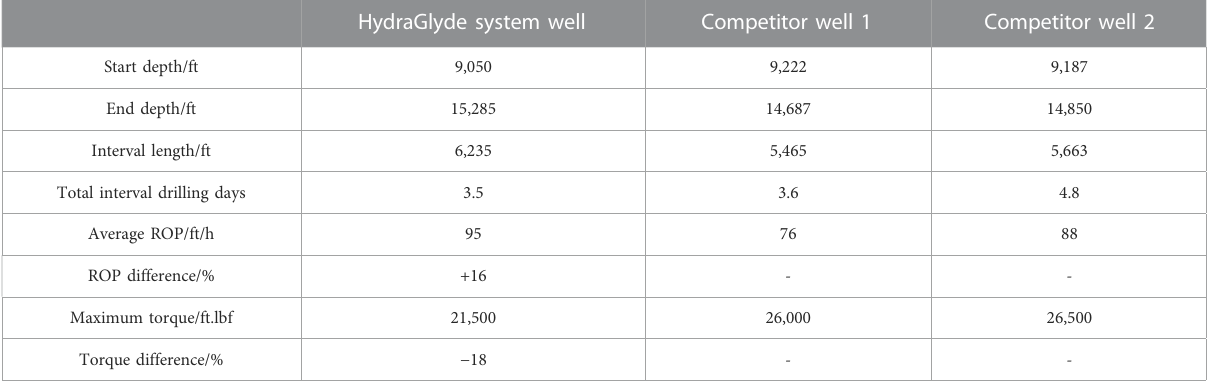
TABLE 3 Comparison of HydraGlyde and other inhibitive water-based drilling fl uids applied in offset